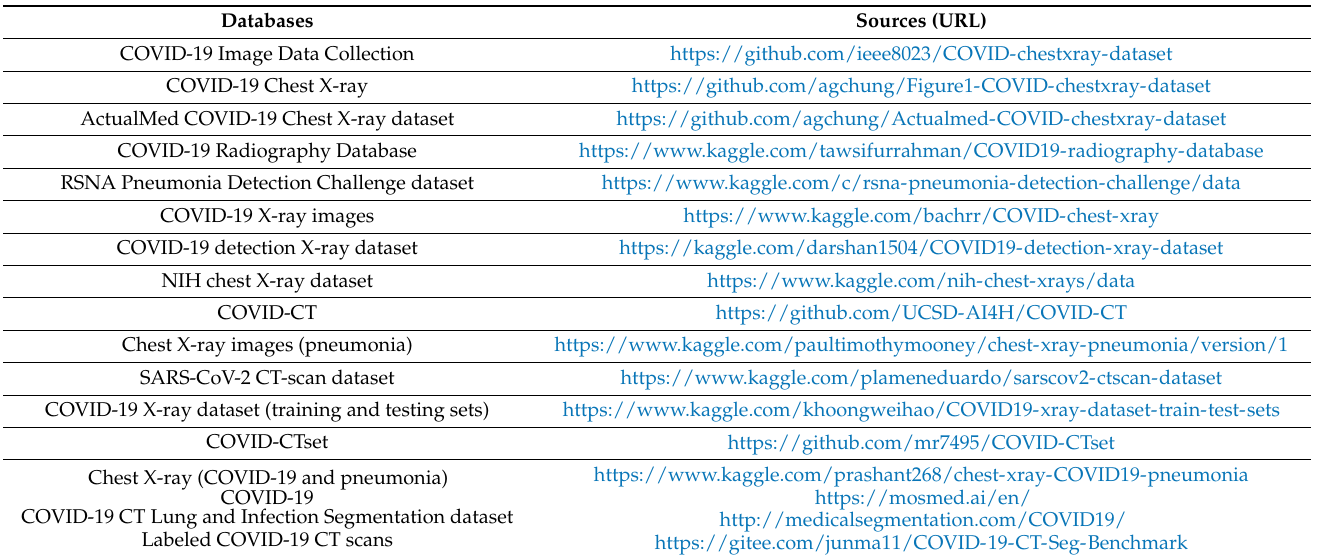
Table 1. Summary of publicly available datasets used in the relevant publications and corresponding URLs (accessed on 17 December 2021).